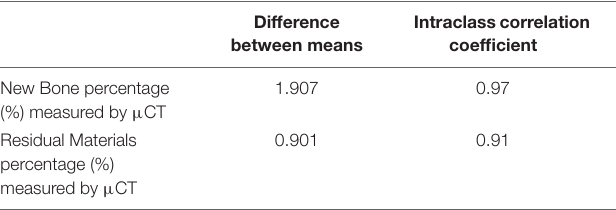
TABLE 2 | The inter-observer reliability for the measurements of new bone percentage (%) and residual materials percentage (%) by µ